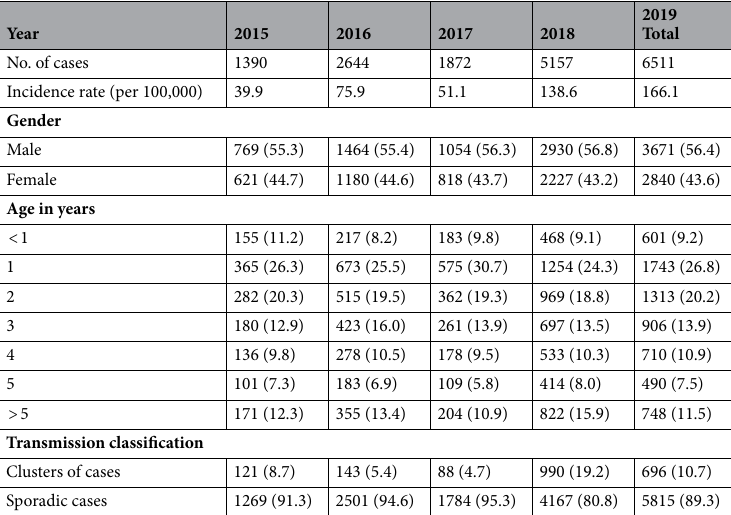
Table 1. Demographic characteristics of hand, foot, and mouth disease cases in Sabah, Malaysia, from 2015 to 2019. Percentage of total is shown in